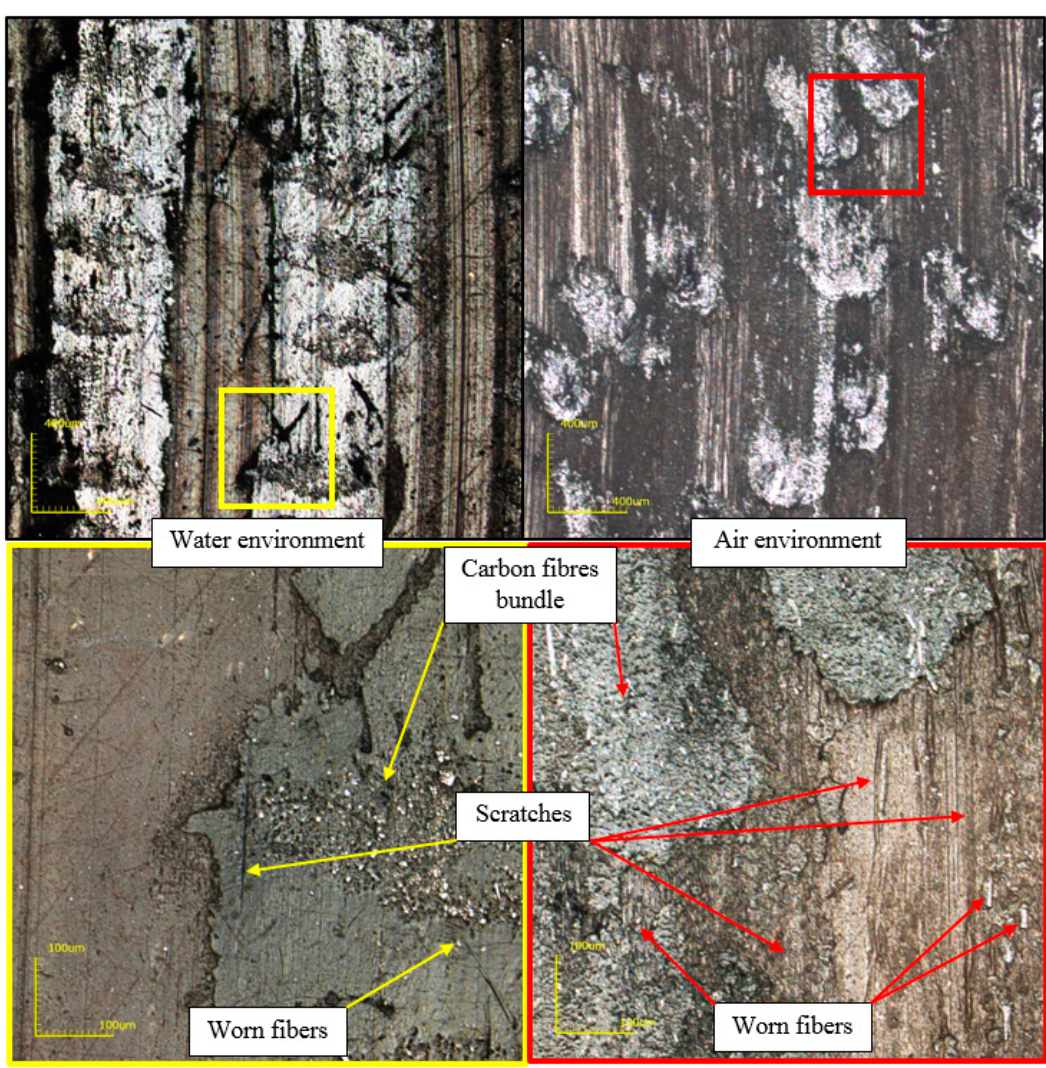
Figure 16. Comparison of friction surfaces of composites tested in water and air.